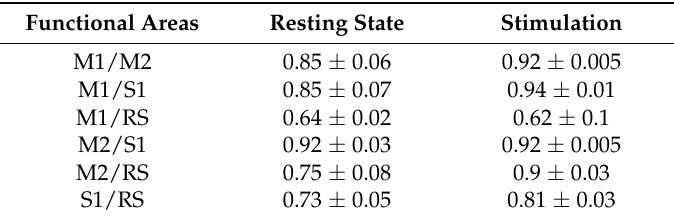
Figure 3. Seed pixel correlation maps of activation during optogenetic stimulation. The panel shows averaged correlation maps for 3 animals, one for each row, during resting state (first row) and optogenetic stimulation. The first and second rows correspond to seed correlation maps of the same mouse during resting state and laser stimulation respectively. In the first column a raw image with the ROIs used for the correlation matrix analysis; the seed is within the ROI. We selected four cortical areas of interest (M1, M2, S1, RS, such as for primary motor cortex, secondary motor cortex, primary sensory cortex and retrosplenial area respectively). The white spot indicates bregma. A, P: Anterior, Posterior. Scale bar: 1 mm. Table 1. Average Pearson’s correlation coefficients between functional areas (first column) are reported both for Resting State and (second column) and optogenetic Stimulation (third column). Values are presented as mean ± standard error mean